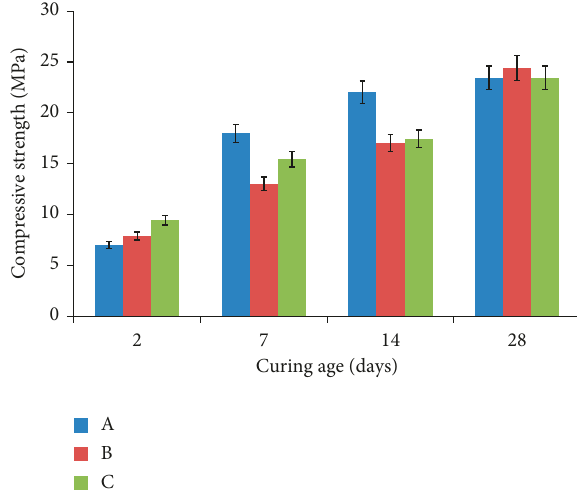
brands of OPC at w/c 0.6.